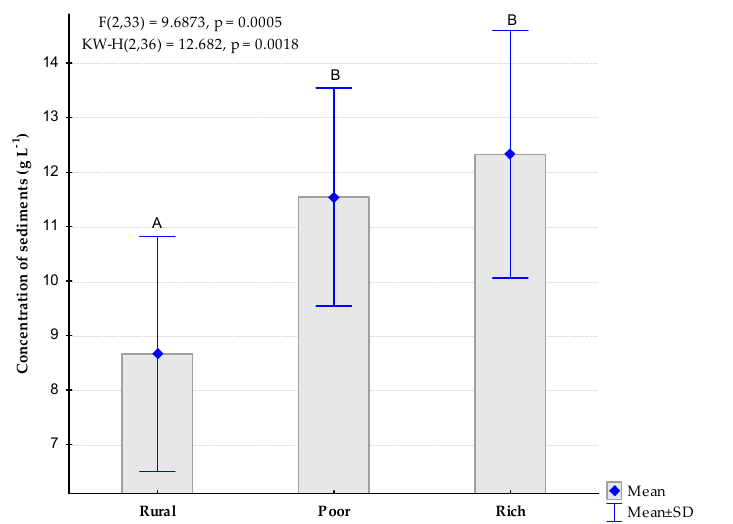
Figure 3. Comparison of mean values of concentration of sediments (g L − 1 ) between the three study areas. Same letters indicate non-different homogenous groups according to the post-hoc LSD-Fisher test ( p <0.05).